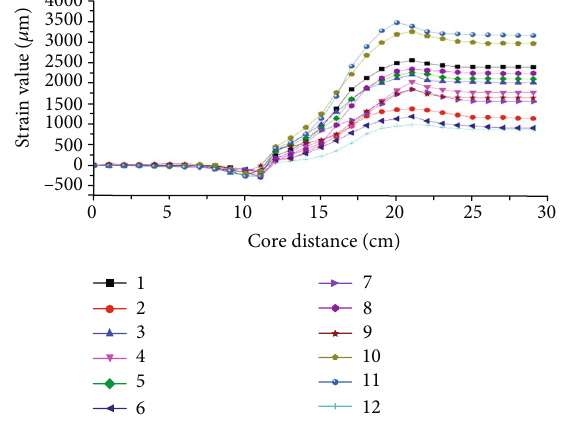
Figure 7: Stress relief curve of no. 3 measuring point. Table 2: Rock mechanical parameters of core at each measuring